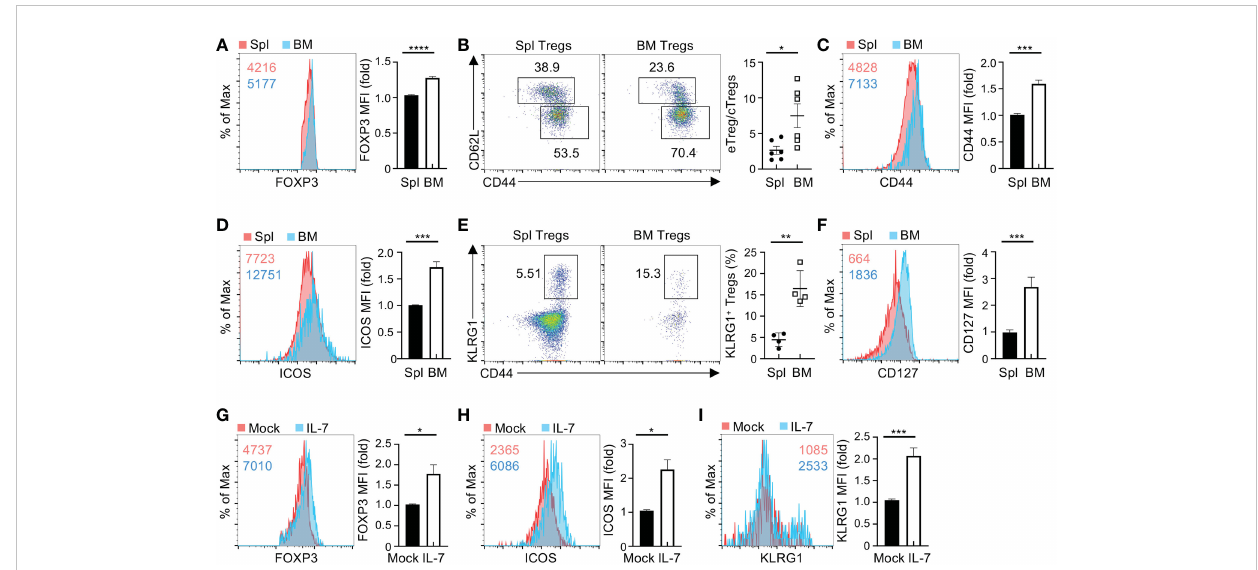
FIGURE 1 BM Tregs express high levels of CD127 and eTreg-associated markers. (A) Flow cytometry analysis of FOXP3 expression in Tregs from the spleen (Spl) and BM of Foxp3 Cre mice. Numbers in graph plot showing mean fl uorescence intensity (MFI) of FOXP3. Right, fold changes of FOXP3 MFI in spleen and BM Tregs. (B) Expression of CD62L and CD44 in spleen and BM Tregs from Foxp3 Cre mice. Right, ratios of CD44 hi Tregs to CD44 lo Tregs ( n = 6 per group). (C, D) Expression of CD44 (C) and ICOS (D) in spleen and BM Tregs from Foxp3 Cre mice. Right, fold changes of CD44 (C) and ICOS (D) MFI in spleen and BM Tregs. (E) Flow cytometry analysis of KLRG1 + CD44 + Tregs in the spleen and BM from Foxp3 Cre mice. Right, frequencies of KLRG1 + CD44 + Tregs ( n = 4 per group). (F) Expression of CD127 on spleen and BM Tregs from Foxp3 Cre mice. Right, fold changes of CD127 MFI in spleen and BM Tregs. (G-I) Expression of FOXP3 (G) , ICOS (H) , and KLRG1 (I) in Foxp3 Cre BM Tregs with mock or IL-7 stimulation. Right, fold changes of FOXP3 (G) , ICOS (H) , and KLRG1 (I) MFI in BM Tregs with mock or IL-7 stimulation. Data are representative of at least three independent experiments (A-I) . Data mean ± s.e.m. P values are determined by two-tailed Student ’ s t -test (A-I) . * P < 0.05, ** P < 0.01, *** P < 0.001, and **** P <